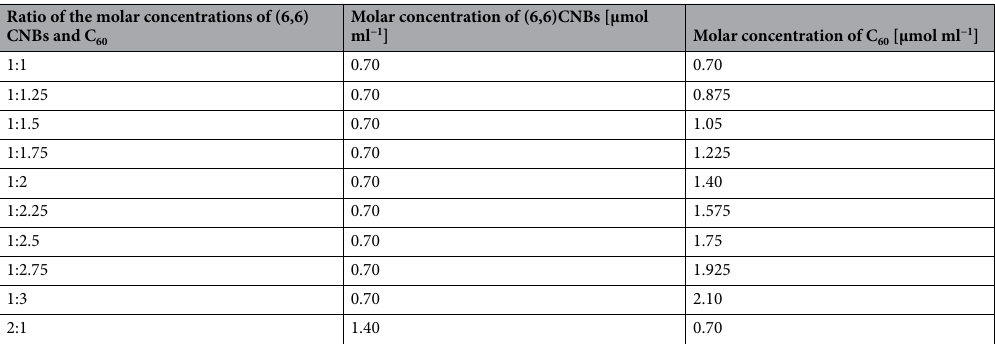
Table 2. Molar concentrations of the solution of CNBs and C 60 dissolved in 1,2-dichlorobenzene. The molar concentrations of (6,6)CNBs and C 60 molecules became half after the mixture of the two solutions.